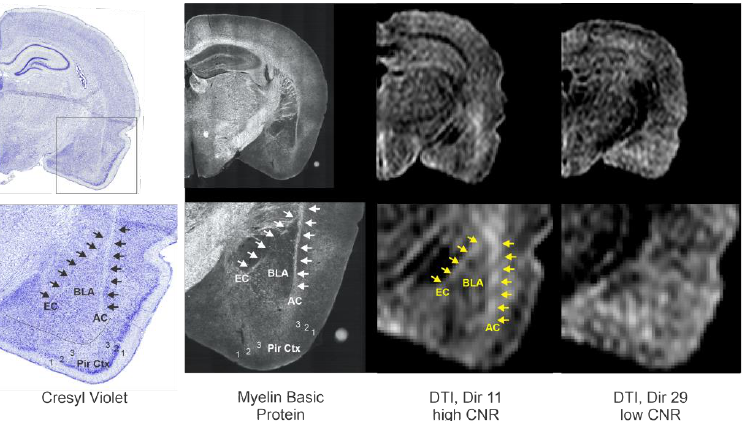
Figure 7. Further confirmation of the ability for DTI to delineate the BLA. To further demonstrate that a specific directional DTI could delineate the BLA, we compared Cresyl violet and myelin basic protein (MBP) stained sections to high and low CNR DTI. The MBP staining provided further verification of known white matter tracts that bound the medial and lateral borders of the BLA, the external capsule (EC) and amgdalar capsule (AC). As can be appreciated, direction 11, which exhibited high CNR values, exhibits clear boundaries of the BLA, whereas a DTI direction with low CNR has little identifiable BLA landmarks. Arrows outline the predominate white matter tracts when observed. BLA — basolateral amygdala, EC — external capsule; white matter, AC — amygdalar capsule, white matter, Pir Ctx — piriform cortex where 1,2,3 identify the cortical layers. Histology is submicron/pixel resolution, whereas DTI is 75 µm/pixel in plane and 600 µm thick. All images are from the same animal.